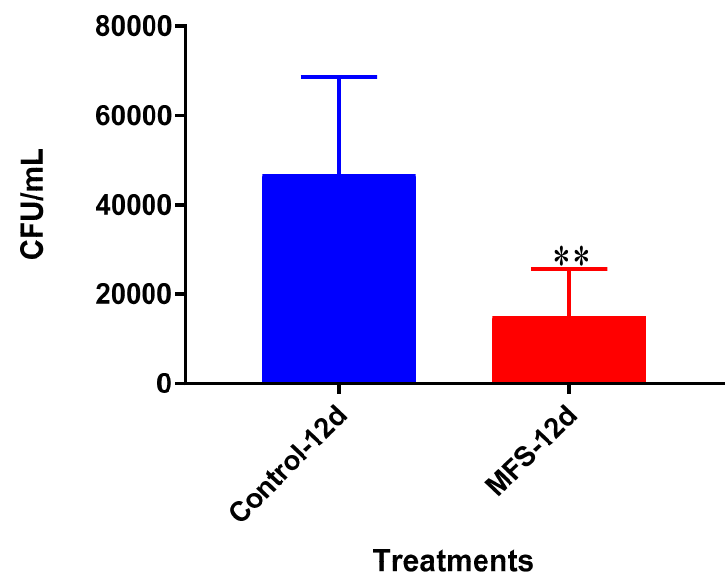
Figure 3. Survival of Mtb Erdman inside untreated and MFS-treated THP-1 macrophages. Data represent means ± SE from 6 trials and multiple plating times. ** p < 0.005 when comparing MFS-treated samples to untreated samples at 12 days.